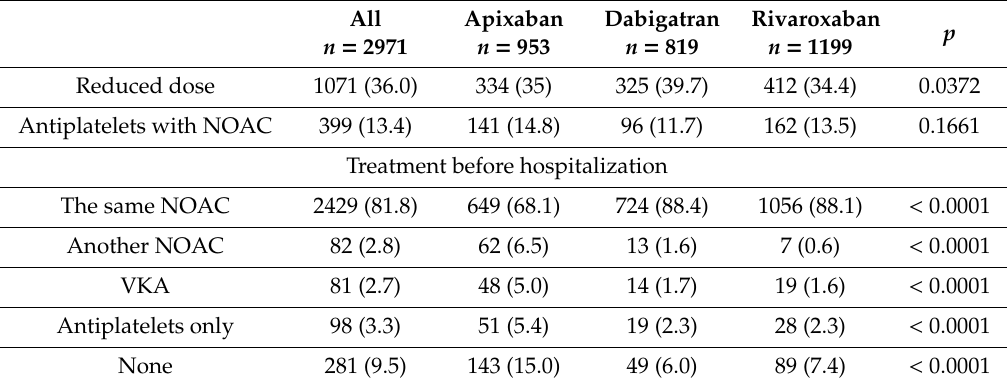
Table 3. Detailed data on anticoagulant therapy in the study group. Abbreviations: NOAC, non-vitamin K antagonist oral anticoagulant; VKA, vitamin K antagonist.